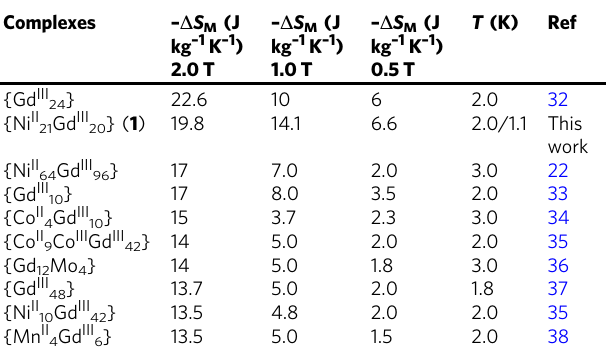
Table 1 Δ S M at low- fi eld (<2 T) for reported polymetallic molecules